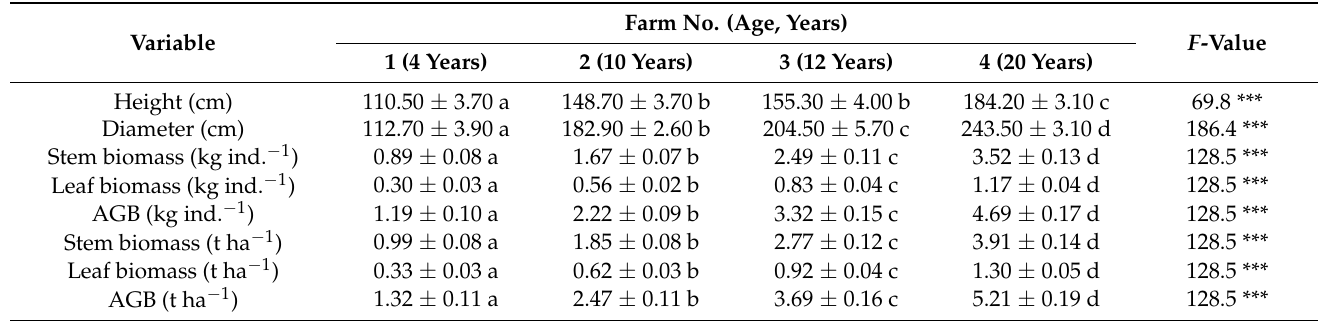
Table 1. Mean ( ± standard error, n = 10) morphological and biomass variables of the Taif rose populations grown in four farms in the mountainous area of Taif City in Saudi Arabia.